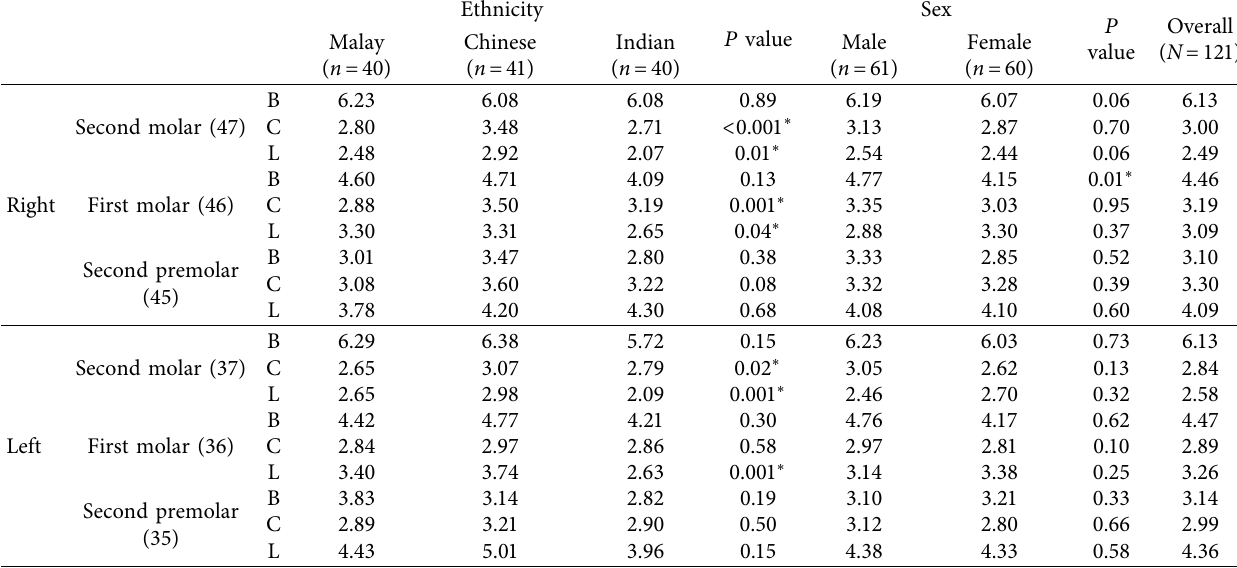
Table 3: The one-way ANOVA and independent t -test results showing the variations in the mean values of B, C, and L according to the ethnicity and sex group among Malaysian population.